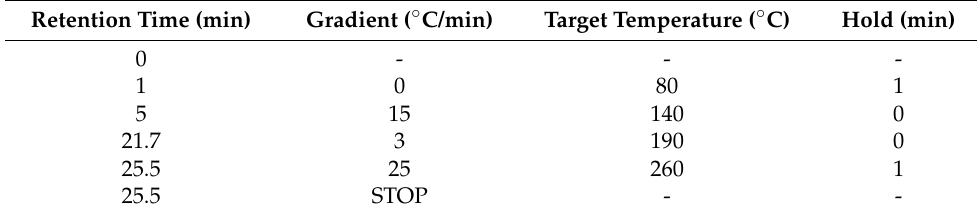
Table 3. Temperature gradient.